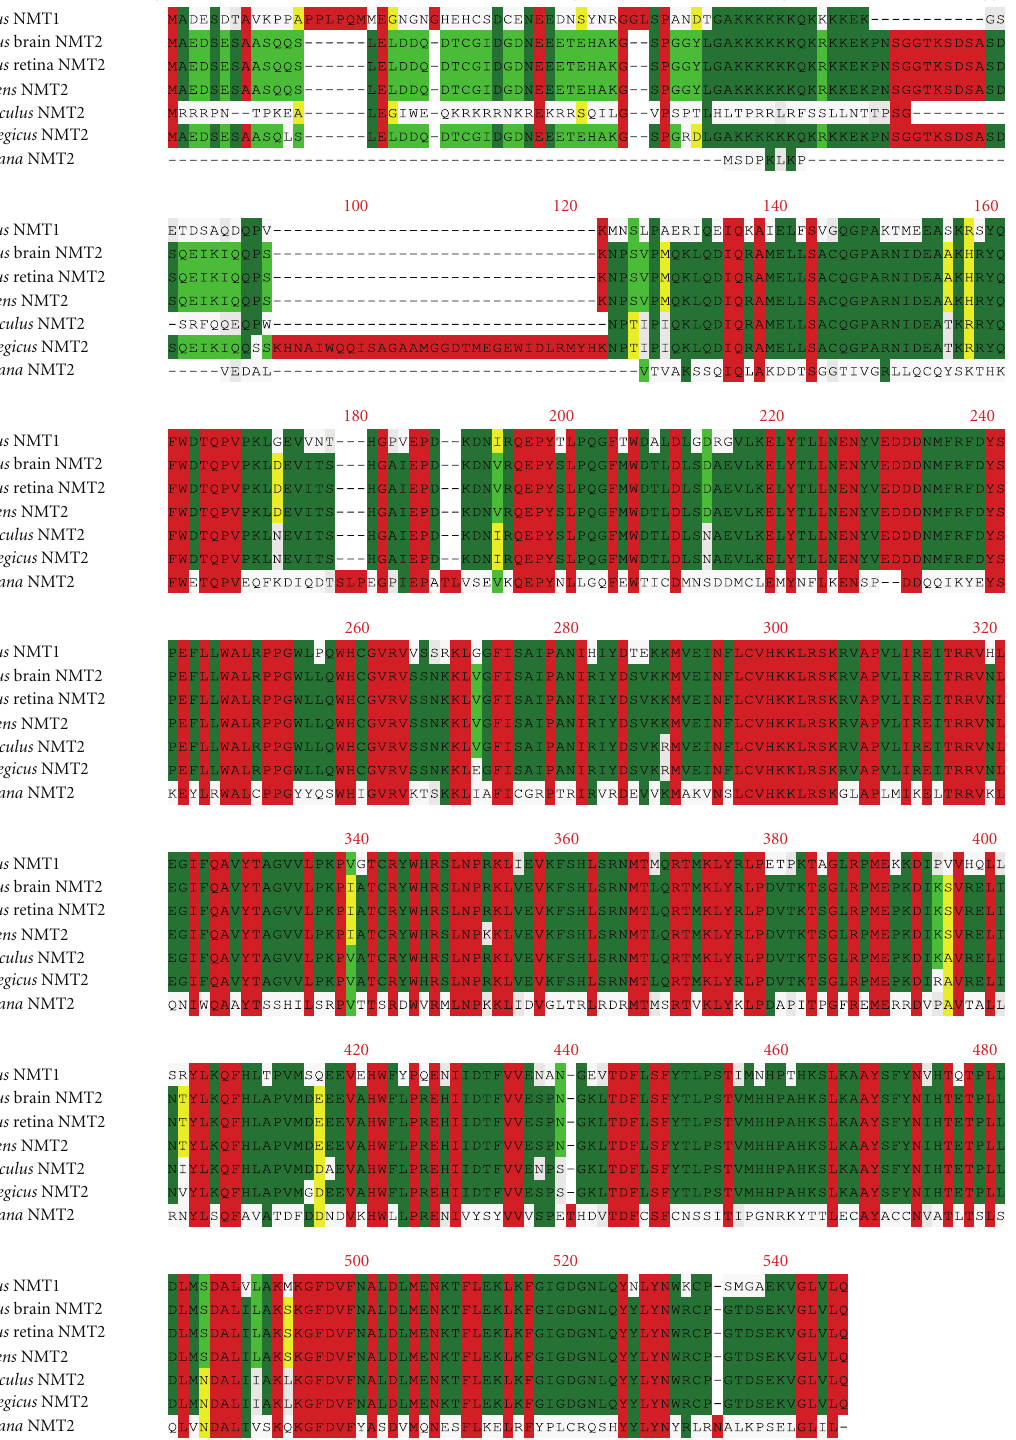
Figure 1: Comparison of the amino acid sequences of di ff erent species of NMT2. The multiple sequence alignment was generated using the ClustralW program. The conservation is represented by the following colors: primary (red, 90–100%), secondary (green, 70–89%), tertiary (light green, 50–69%), and quaternary (yellow, 30–49%). The deduced amino acid sequence of bovine brain NMT2 was aligned with B. taurus retina, AAA73914; H. sapiens , NP005337; M. musculus , AAC84169; R. norvegicus , CAA52328; A. thaliana ; AAC23421; NMT1 B. taurus ,